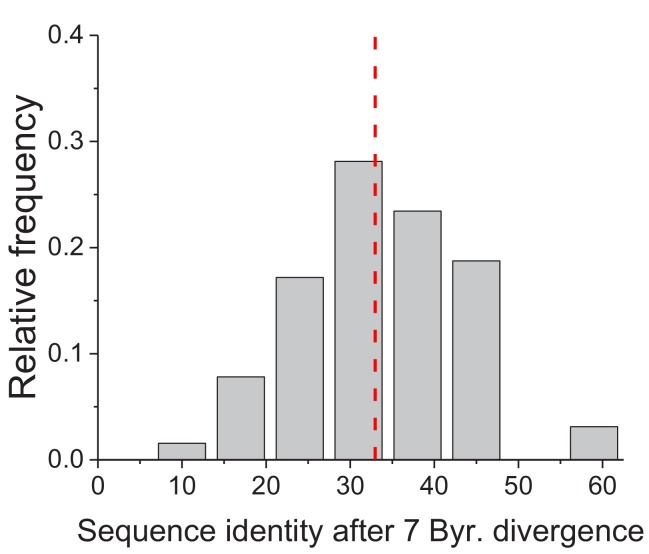
Projected long-term sequence identity of metabolic orthologs.The distribution, across 64 EC numbers, of the projected global sequence identity after 7 billion years of sequence divergence according to the Model 3 (Equation 3). The vertical dashed red line represents the median value of the distribution (33%).